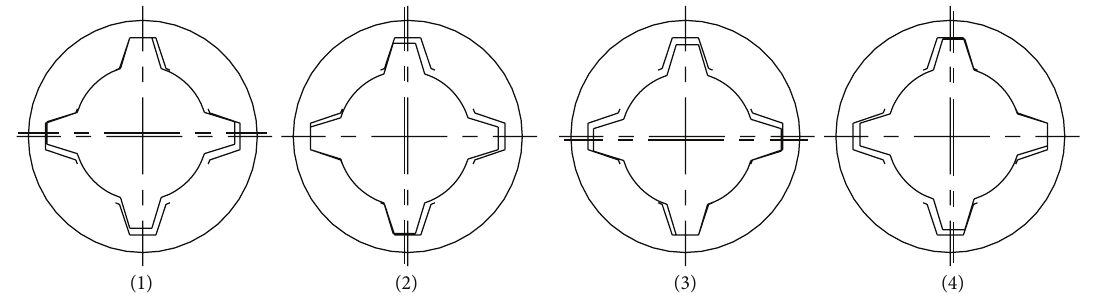
Figure 11: Drum tooth coupling mesh diagram.